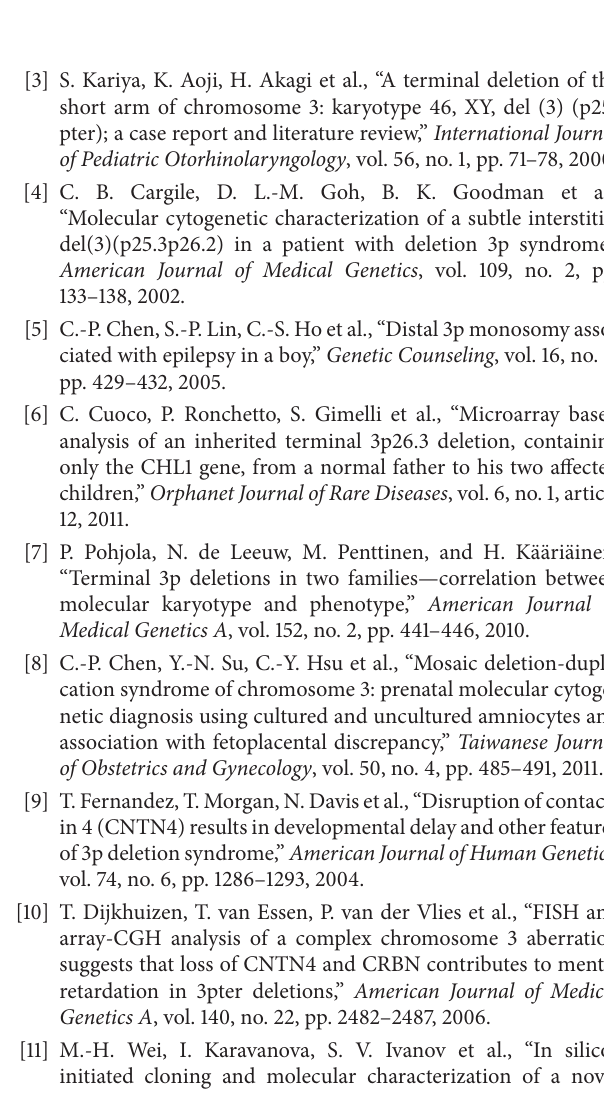
Figure 3: Schematic of hypothetical meiotic and mitotic recombination events leading to the observed allelic and copy number imbalances in the proband. (a) Shows a possible exchange between homologous chromosomes at meiosis that could lead to a copy number gain in two neighbouring genes (labelled G1 and G2); the coloured boxes represent flanking alleles of a repetitive sequence. (b) Shows the homologous chromosomes 3 of the proband at conception. (c) Shows a possible early mitotic event (between homologous copies of chromosome 3) during development of the proband that would give rise to interstitial segmental isodisomy in the region bounded by genes 1 and 2. The contribution of this cell line with that of the cell line represented in (b) would be consistent with the allelic imbalance and copy number data of the